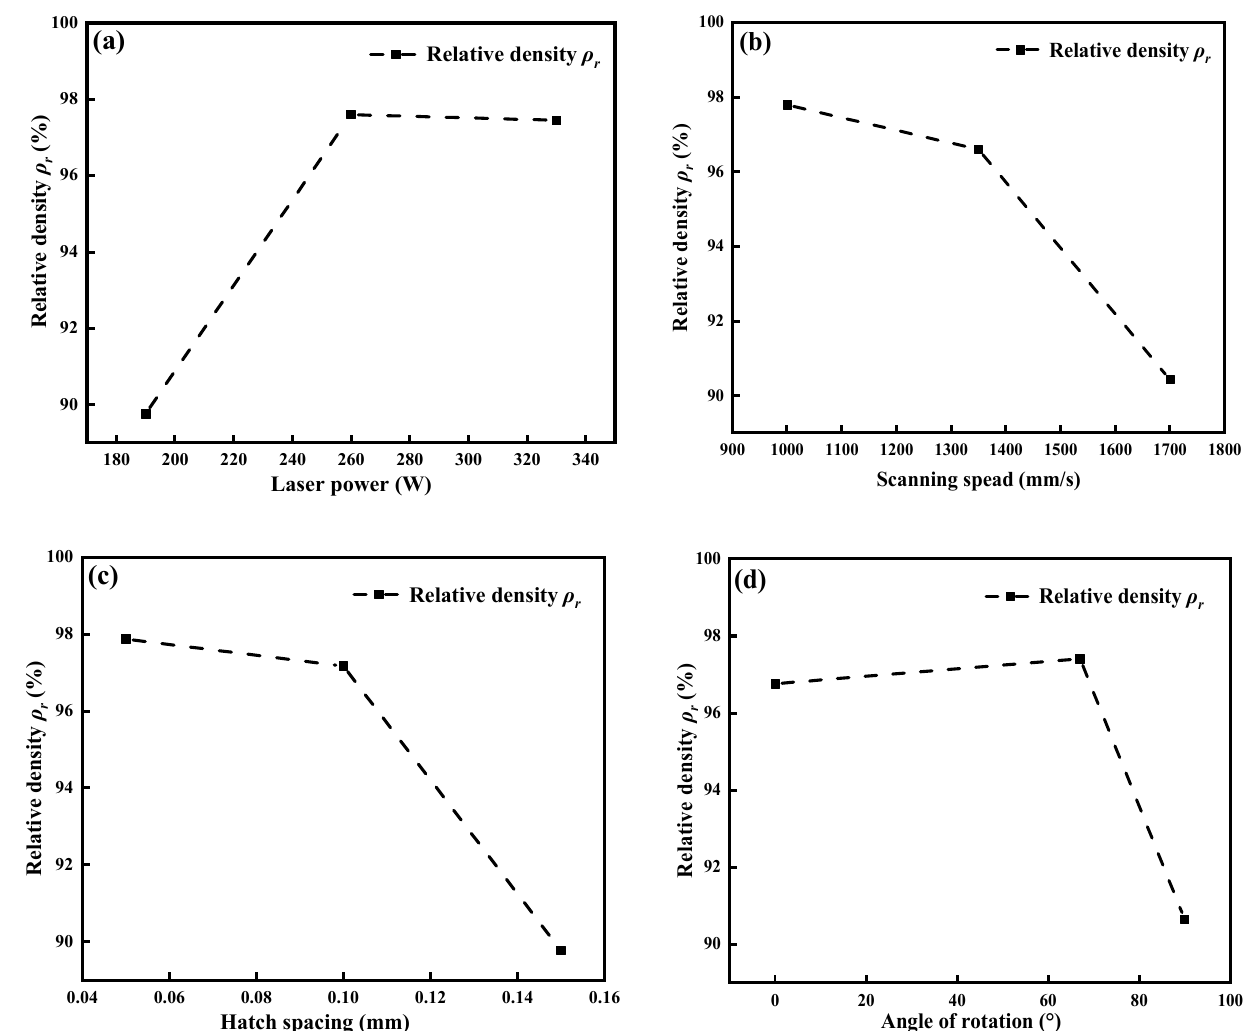
Figure 6. Various factors of orthogonal test for 316 L stainless steel: ( a ) laser power parameter factors; ( b ) scanning speed parameter factors; ( c ) hatch spacing parameter factors; ( d ) rotation angle parameter factors. Table 5. Effect of process parameters on relative density using Archimedes method.